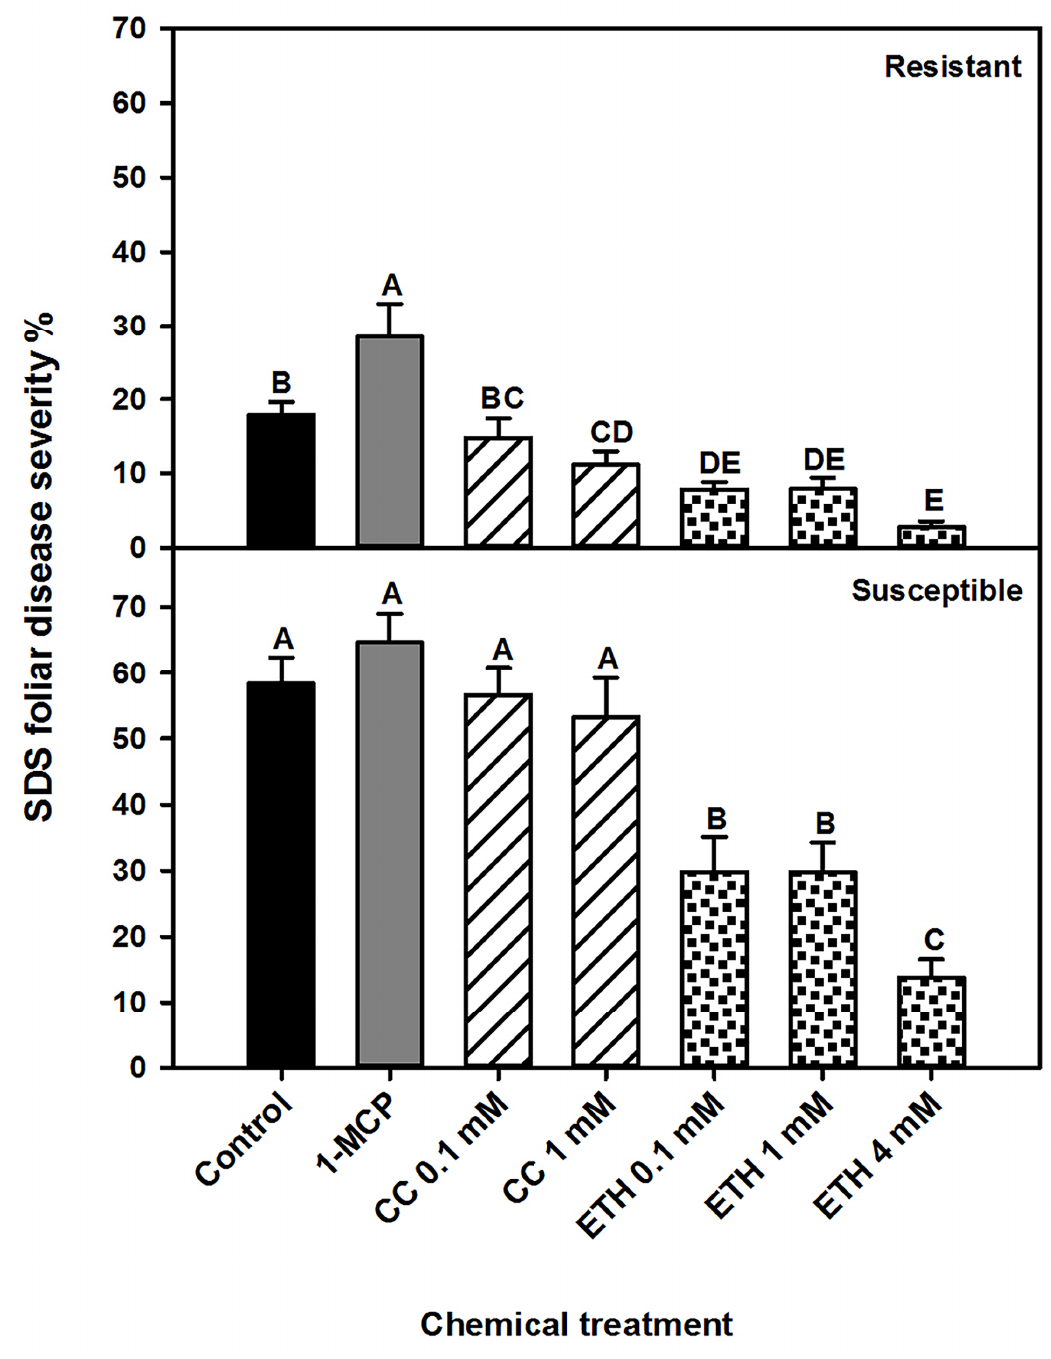
Fig 2. Effect of chemical treatments on severity of foliar symptoms of soybean sudden death syndrome in resistant cultivar MN106 and susceptible cultivar Williams 82. Soybean seedlings were drenched with water (control), ethephon (ethylene inducer) at concentrations of 0.1 mM, 1 mM, and 4 mM, or cobalt chloride (ethylene suppressor) at concentrations of 0.1 mM, and 1 mM, 24 h before and 24 h after transplant into soil infested with Fusarium virguliforme . 1-MCP (ethylene perception suppressor) was sprayed until run off at the same times. SDS symptoms were assessed 21 days post inoculation (DPI). Each bar represents the mean of 21 replicates (7 cups × 3 runs), and the error bar represents the standard error of the mean. Means with different letters are significantly different ( P <